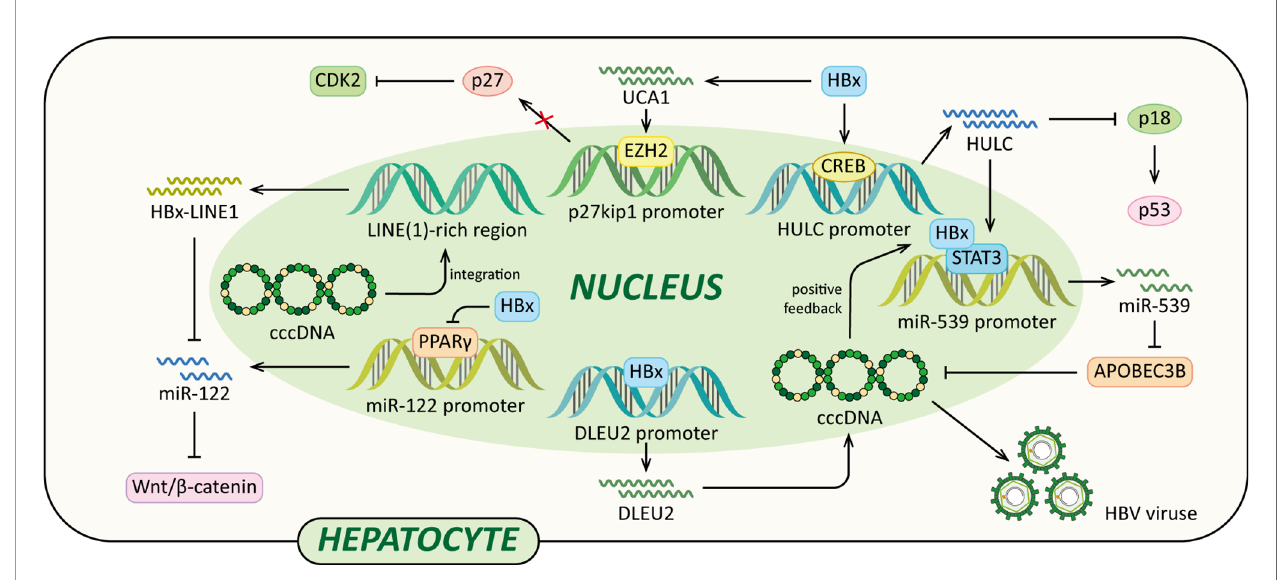
FIGURE 5 | Regulatory models of HBx and lncRNAs involved in liver pathogenesis. The mechanisms involved in HBx and lncRNAs are related to epigenetic modulation, Vimentin, miR-122, Wnt/ b -catenin signaling pathway, p18, miR-539 and p27, which cause elevated HBV transcription and replication, EMT, diminished p53, cccDNA stability, cell growth, anti-apoptosis and eventually